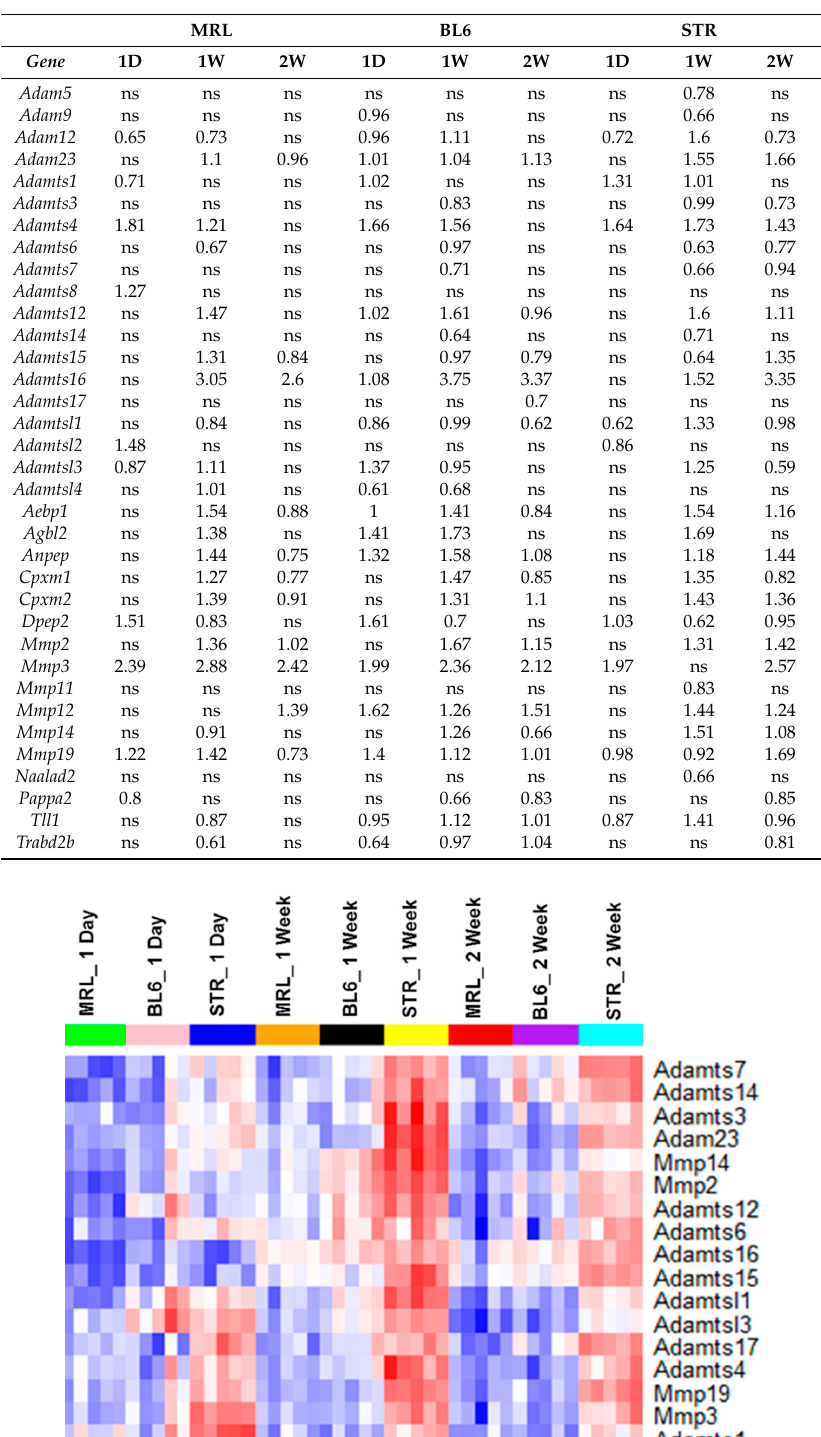
Table 2. Metallopeptidases upregulated in knee joints after ACL injury. Fold upregulation (log2 scale) in injured joints compared to uninjured joints are shown in the table. ns: not significantly differentially expressed.